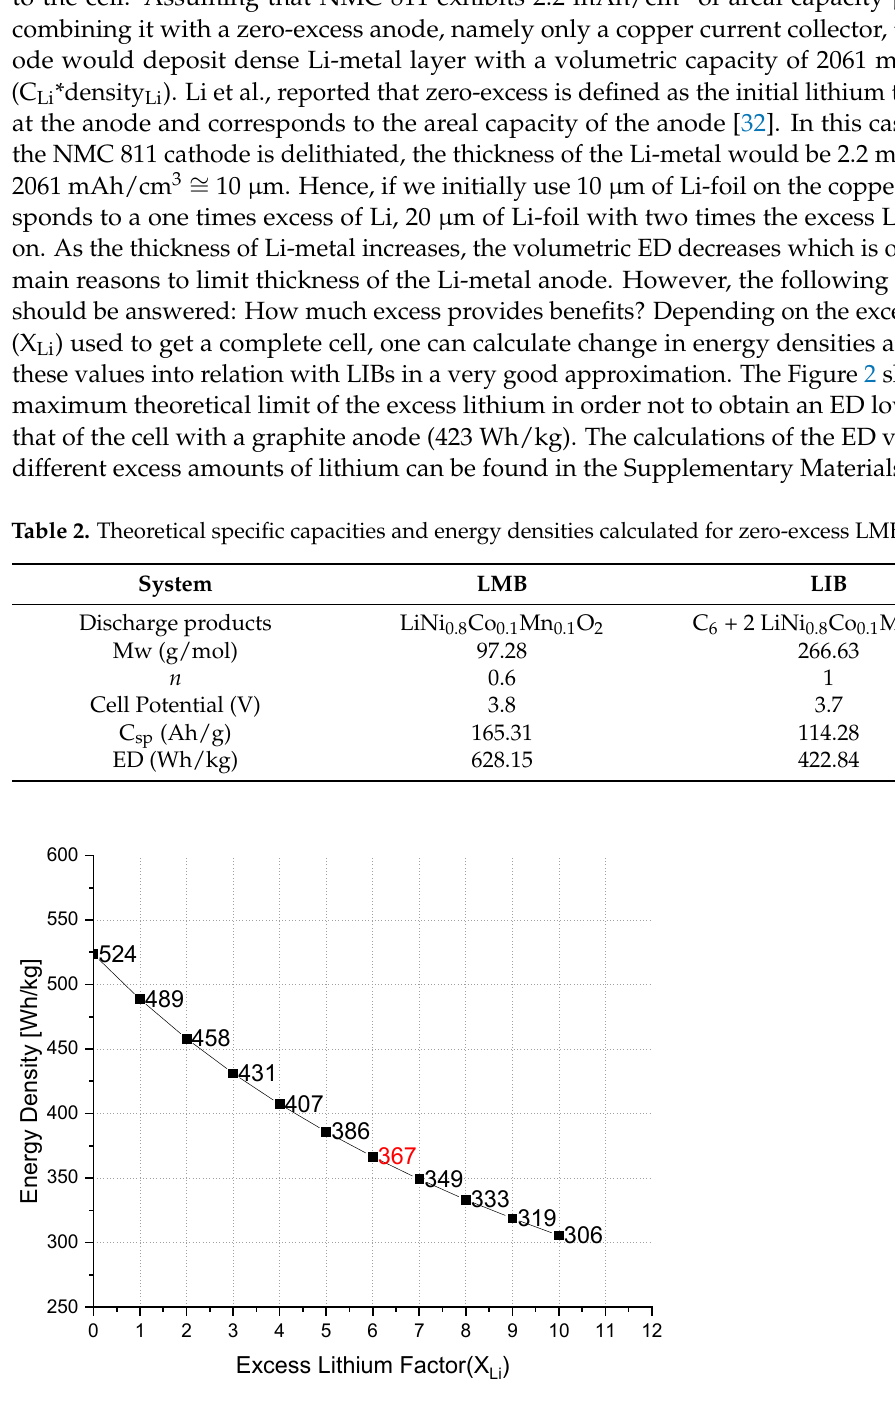
Figure 2. Change of EDs with different factors of excess lithium on the anode .